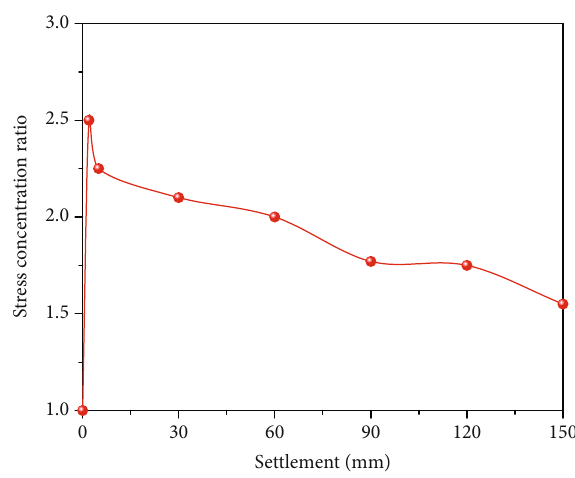
Figure 11: Stress concentration ratio with